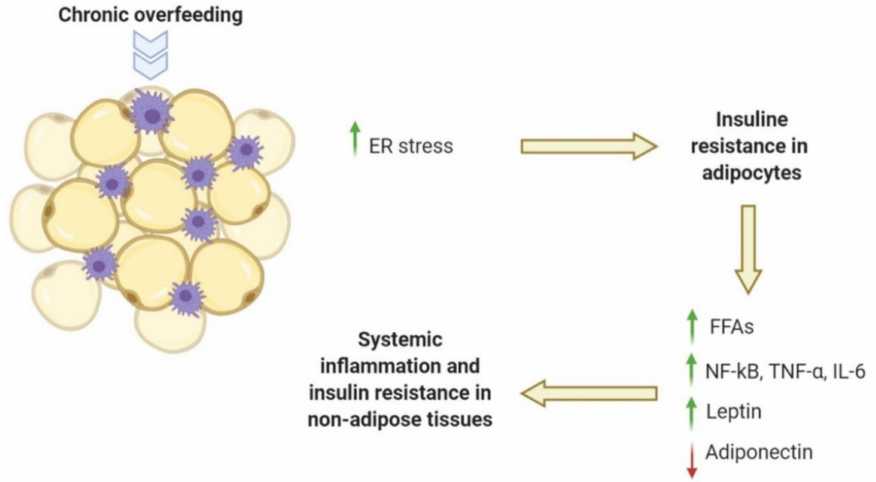
Figure 1. Chronic overfeeding causes an increase in adipose tissue depots leading to systemic inflammation. Adipocyte hypertrophy is a possible stress condition for the endoplasmic reticulum (ER), which in turn activates inflammatory pathways and causes insulin resistance in adipose tissue. Insulin-resistant adipocytes induce an increase in circulating free fatty acids (FFAs), synthesis of pro-inflammatory cytokines, and an alteration of leptin and adiponectin levels, triggering ectopic accumulation of lipids, systemic inflammation and insulin resistance in non-adipose tissues. The red arrow indicates decrease, and the green arrows indicate